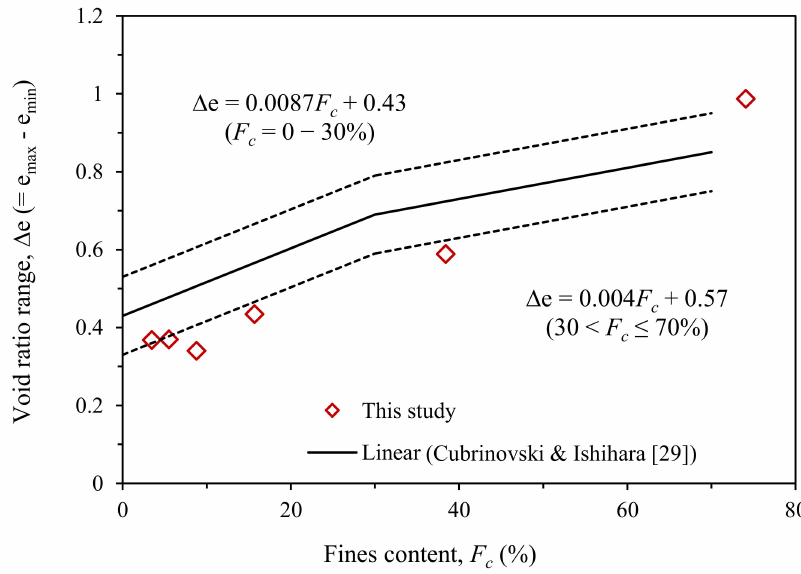
Figure 5. Regressions of fine contents and void ratios.